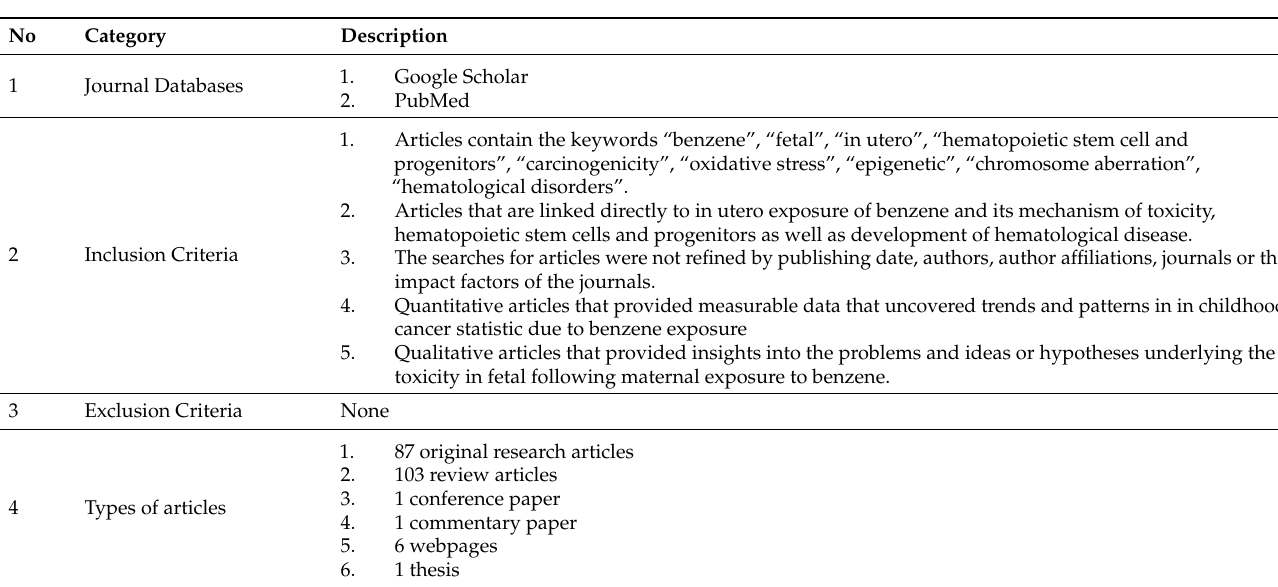
Table 2. Summary of the article selection criteria used to construct this